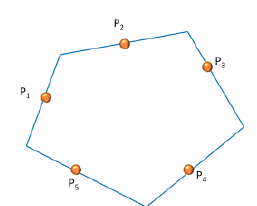
Figure 17. Perimeter with Catmull – Rom